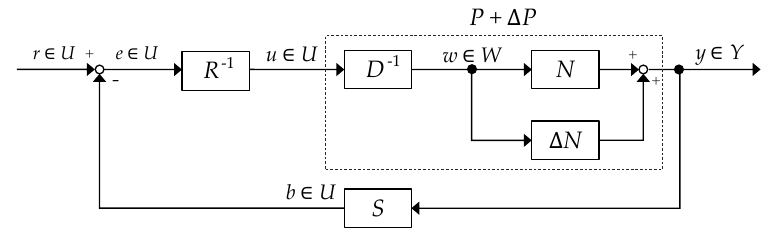
Figure 4. The nonlinear feedback control